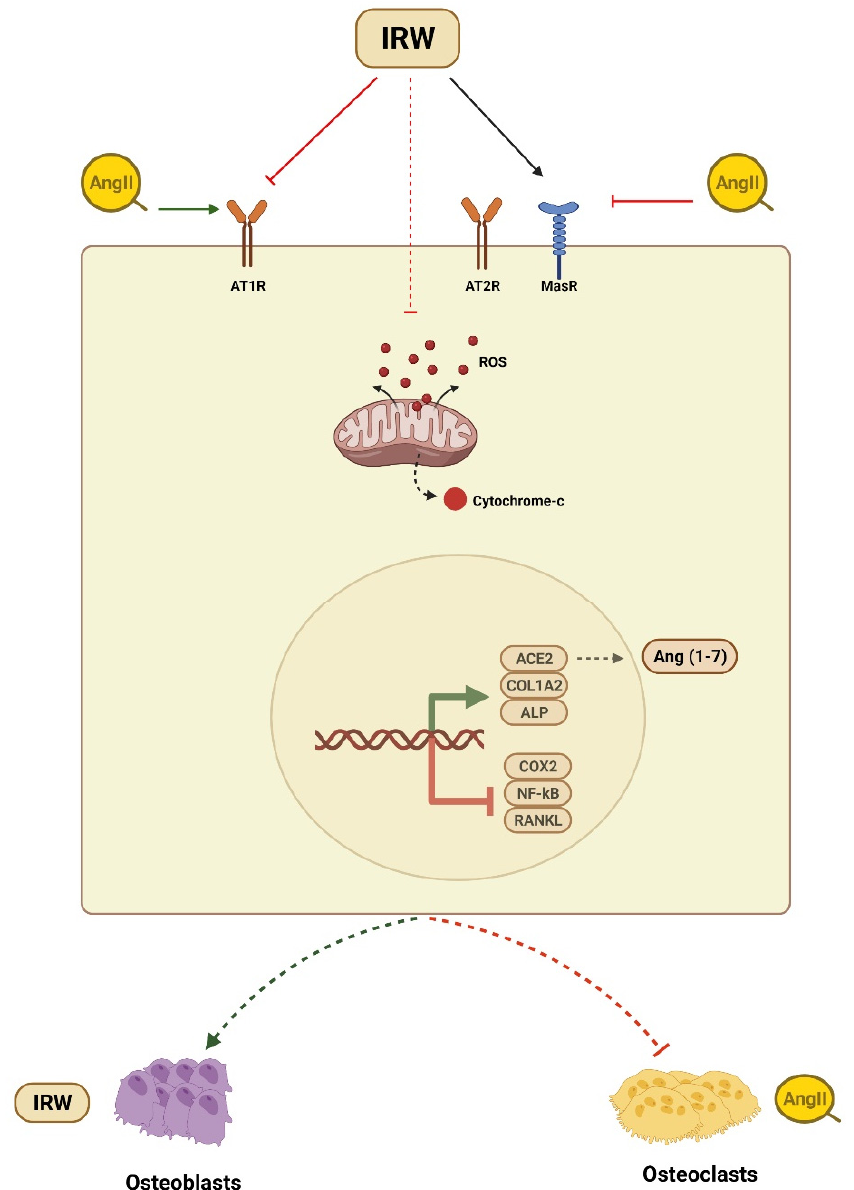
Figure 6. Summary of cytoprotective and osteogenic impact of IRW against Ang II stimulation.